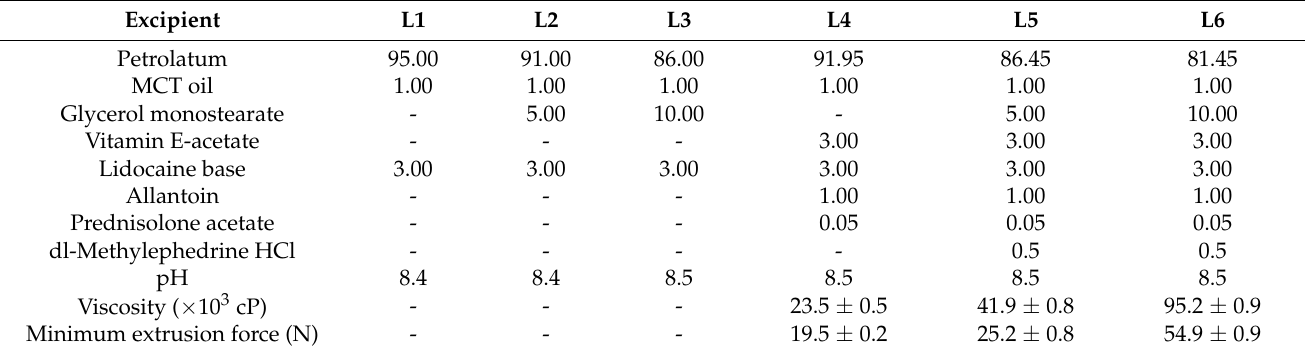
Table 1. Formulation and rheological characterization of lidocaine